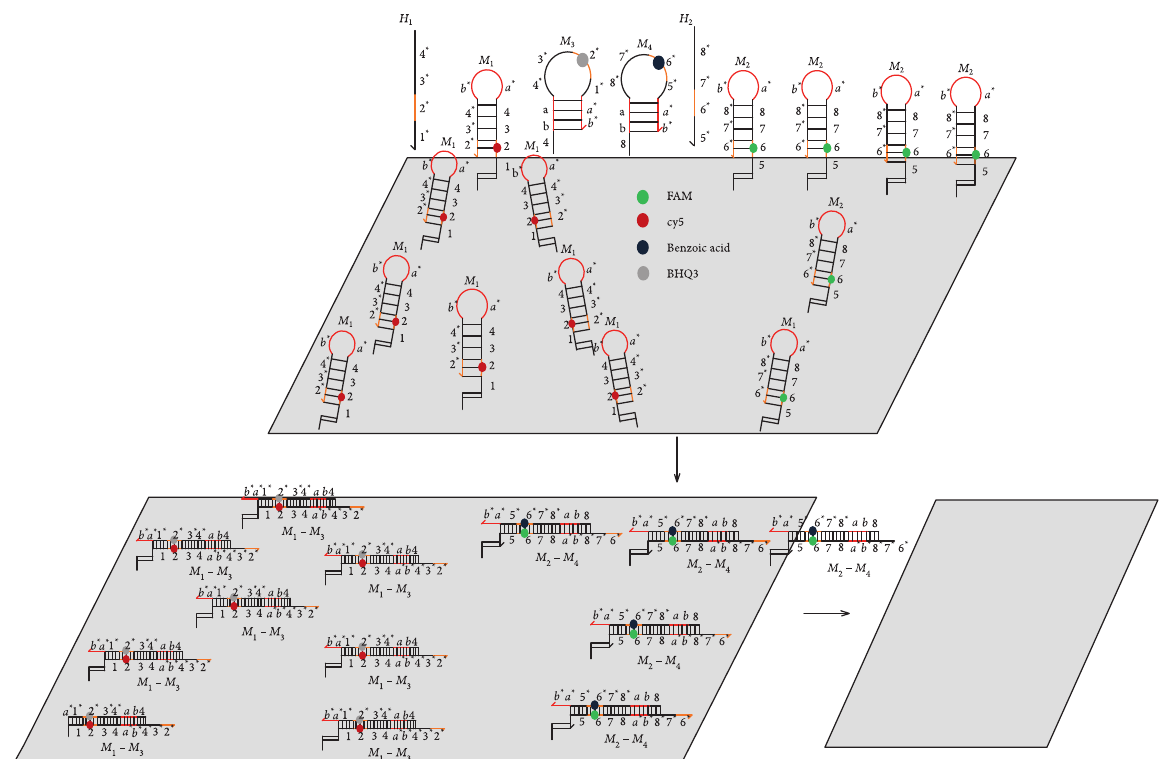
Figure 14: The case of NAND gate input (1,